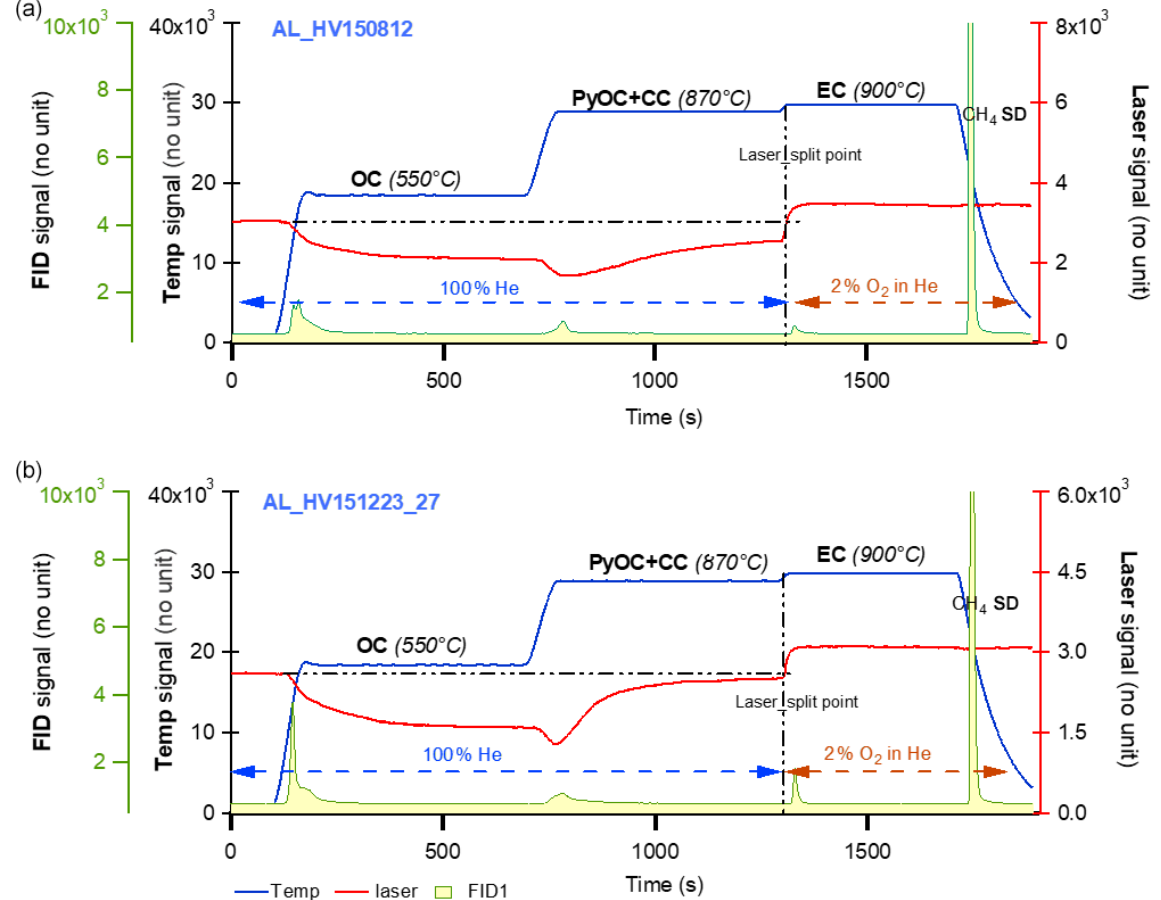
Figure 8. Thermograms of fine particles (PM 1 . 0 µm) from the filter samples collected at an arctic site, i.e., Alert, NU, Canada, in summer (a) and winter (b) 2015. The legends are the same as Fig. 6. It is clearly shown on both thermograms that during 550 ◦ C stage, the laser signal starts decreasing (implying charred OC formation) and begins increasing at 870 ◦ C and reaches the initial value before the EC stage (indicating the contribution to EC by charred OC is minimized or